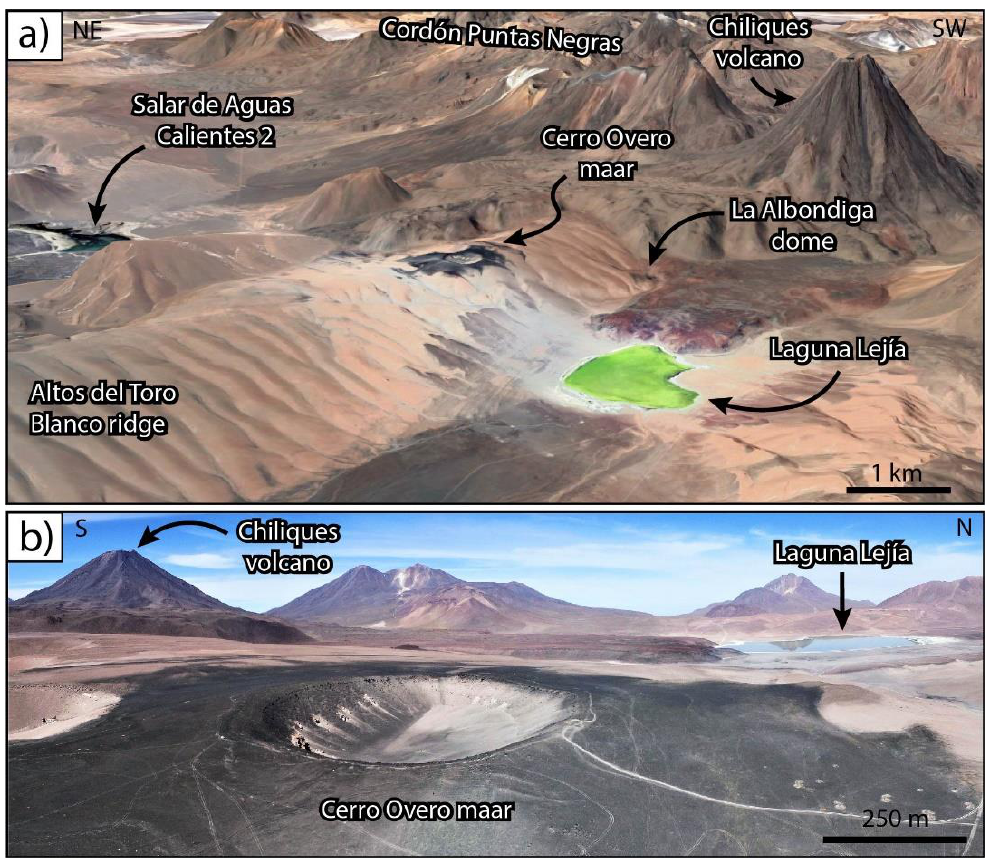
Figure 5. Cerro Overo maar. ( a ) Satellite image taken from Google Earth TM , showing the location of the Laguna Lejía, Salar de Aguas Calientes 2, and the morphology of the surface. ( b ) Aerial view of the Cerro Overo maar.